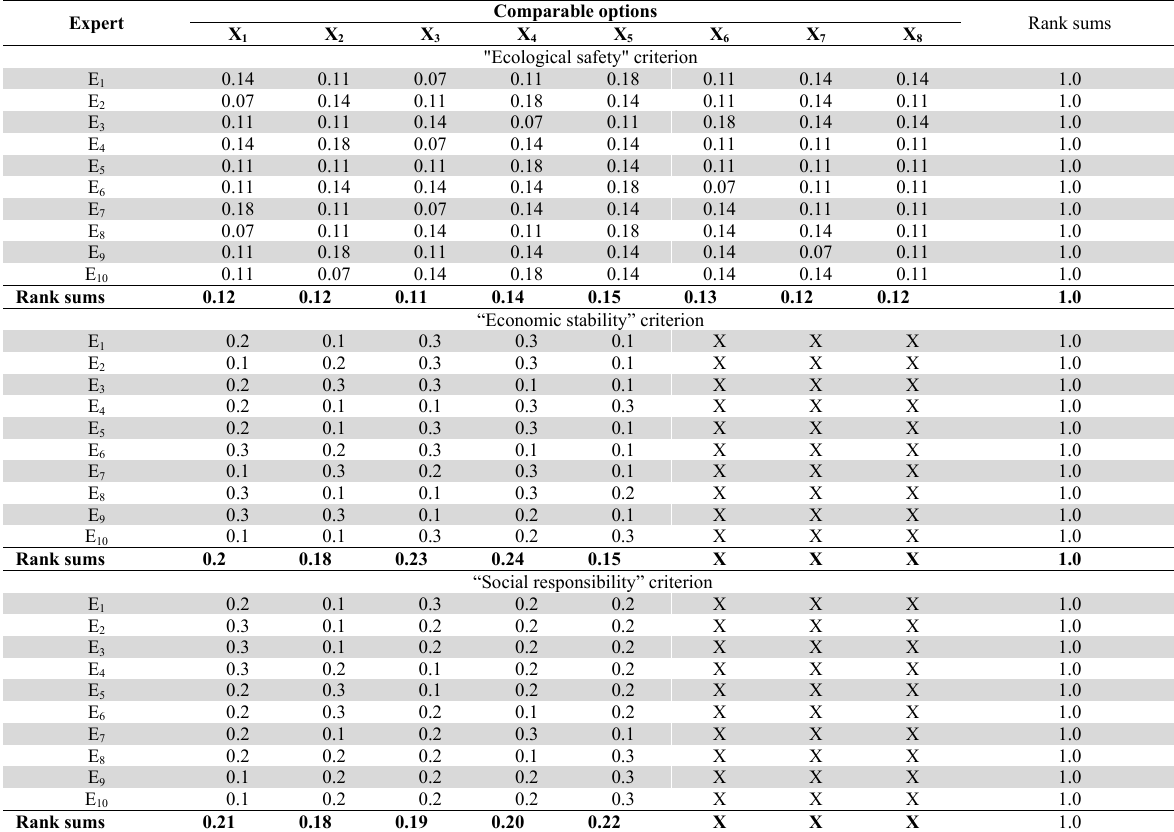
Summary data of experts’ preferences options of stakeholders’ interests of the studied enterprise on levels of importance in the parameter of “ecological safety”, “economic stability” and “social responsibility” criteria